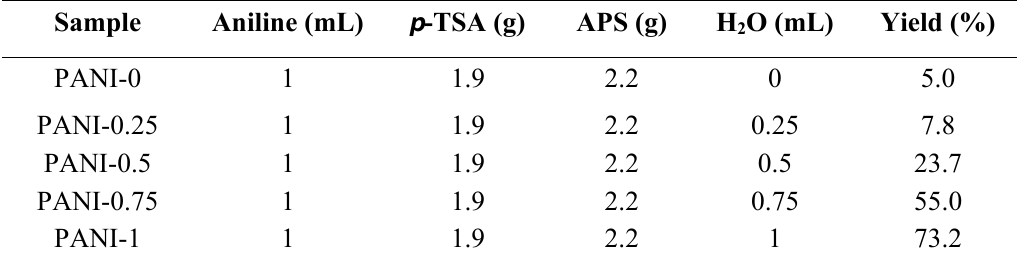
Table 1. The mass of reactants and the yield of obtained PANI